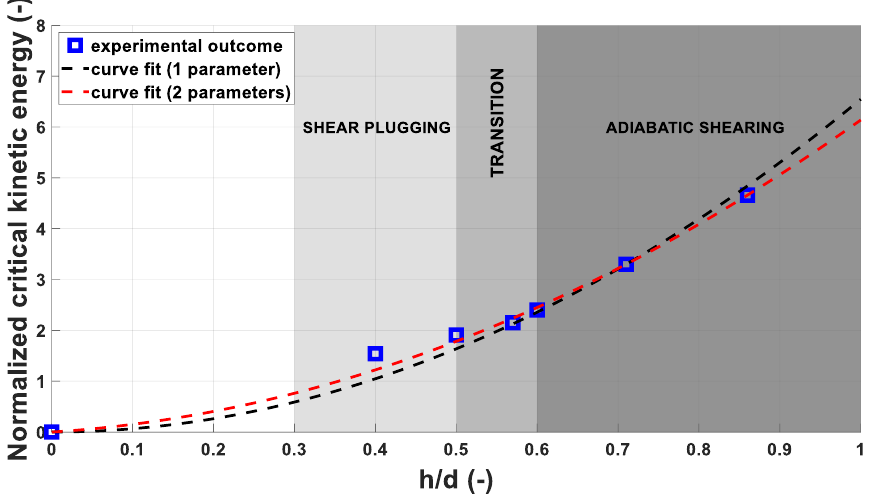
Figure 15. 𝐸̃ 𝑘𝑖𝑛𝑐𝑟𝑖𝑡 over h/d for every fragment-plate combination.